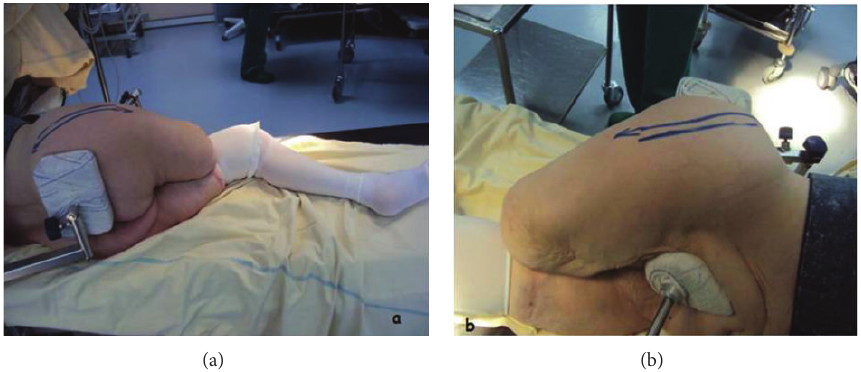
Figure 2: Intraoperative photographs demonstrating the setup of the patient.